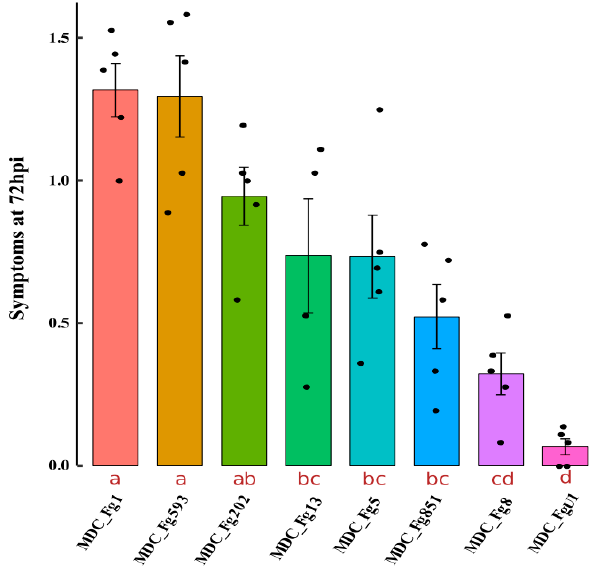
Figure 5 . Symptom severity produced by the eight F. graminearum strains in bread wheat spikes during the FHB disease progress. The eight strains of F. graminearum were inoculated on the Recital wheat cultivar and symptoms were monitored at 72 hpi according the scoring described by Fabre et al. [56]. The Y -axis represents the symptom severity scale ranging from 0 to a maximum of 4. The error bars are the means ± SE of five biological replicates, and each replicate was characterized by the average value (represented as black dots) computed from six spikelets of three inoculated spikes. The different letters indicate significant differences at p ≤ 0.05 (Duncan’s multiple range test for post-hoc ANOVA mean separation).